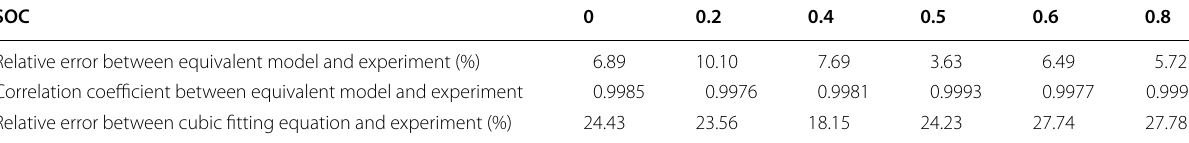
Table 6 Relative error and correlation coefficient R 2 among equivalent model, cubic fitting equation and experiment